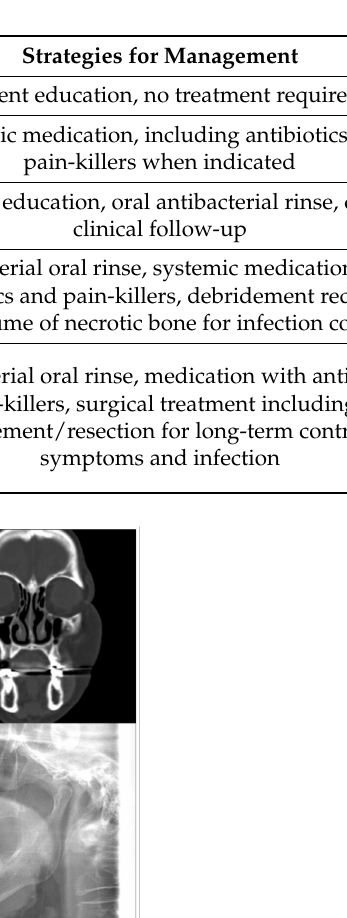
Table 2. Staging of MRONJ [2].